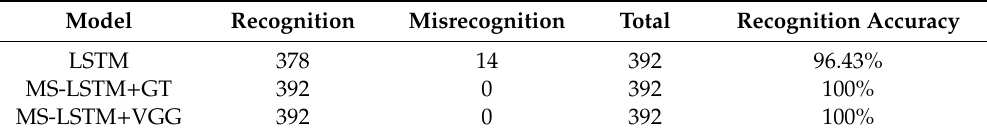
Table 6. Performances of the 3 networks with respect to normal samples in validation set.